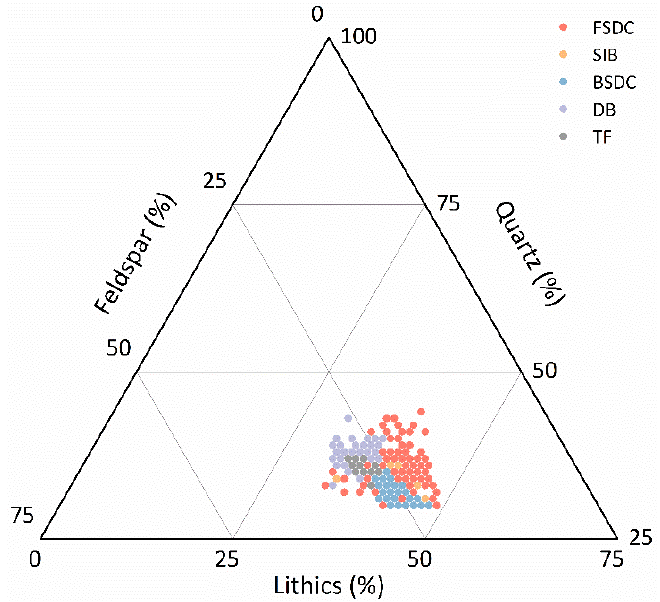
Figure 7. Quartz – feldspar – lithic classification of sandstones in the No. 1 structural belt using the Figure 7. Quartz–feldspar–lithic classification of sandstones in the No. 1 structural belt using the diagram diagram of Folk [40]. (FSDC — submerged distributary channel (fan delta), SIB — submerged inter- of Folk [40]. (FSDC—submerged distributary channel (fan delta), SIB—submerged interdistributary bay, distributary bay, BSDC — submerged distributary channels (braided delta), DB — distal bar, TF — tur- BSDC—submerged distributary channels (braided delta), DB—distal bar, TF—turbidite bidite fan).